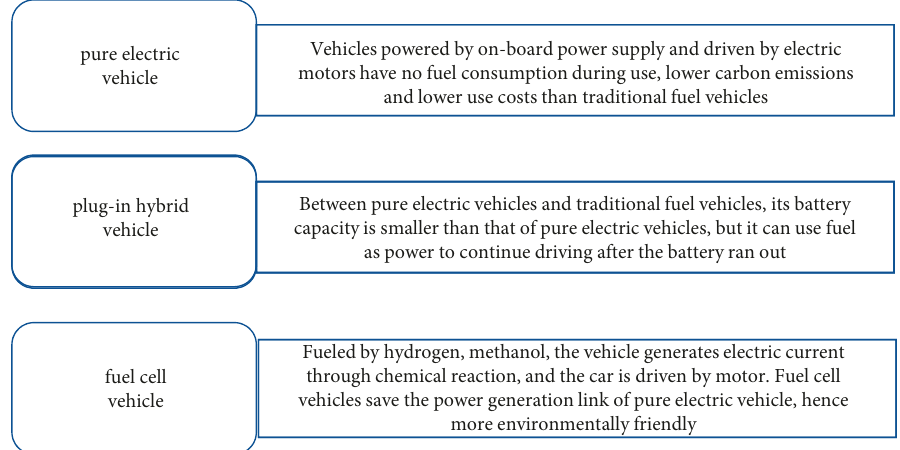
Figure 7: Introduction to the main types of new energy